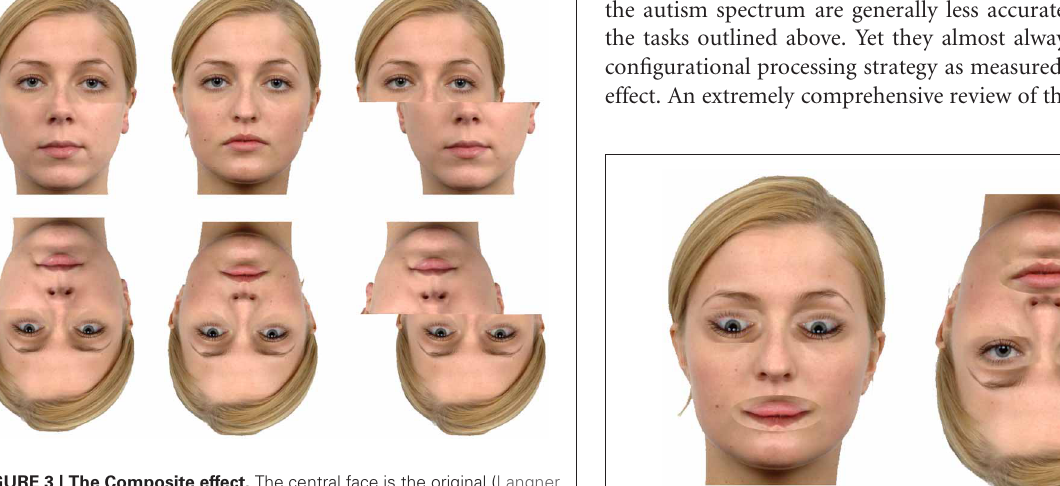
FIGURE 3 | The Composite effect. The central face is the original (Langner et al., 2010) while the left and right faces are composites of two identities. The identity of one half of the face is easier to match when the two halves of the face are misaligned ( Right ) compared to aligned ( Left ). This effect is reduced when the faces are turned upside down reflecting the lack of interference from integration across the whole face when inverted.